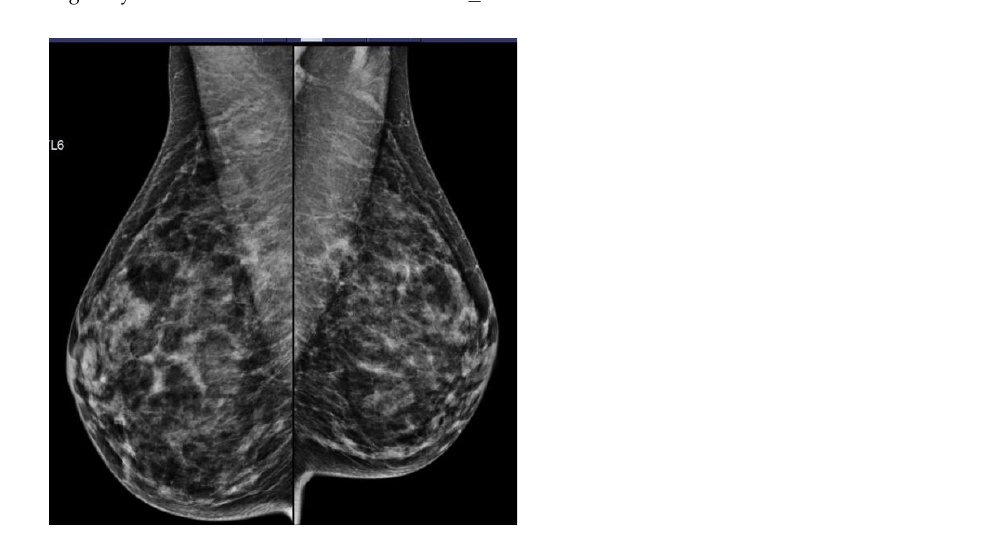
Figure 2. 42-year-old woman with a strong family history of BC shown to have BI-RADS category C breast tissue on screening mammograms. When BTD was incorporated into IBISv8 calculation, the lifetime risk increased from 24.2% to 32.4%, and she became eligible for HROBSP screening with B-MRI.